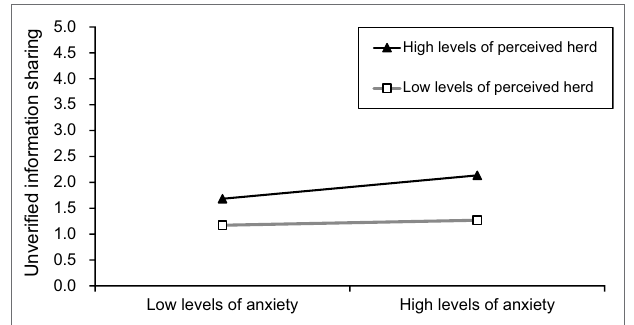
FIGURE 2 | Interaction effect of anxiety and perceived herd on unverified information sharing.